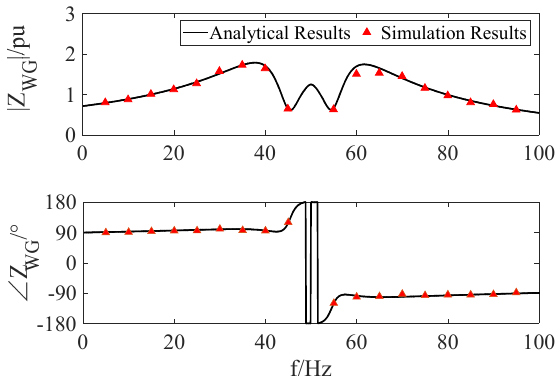
Figure 8. Comparison between simulation results and analytical results.